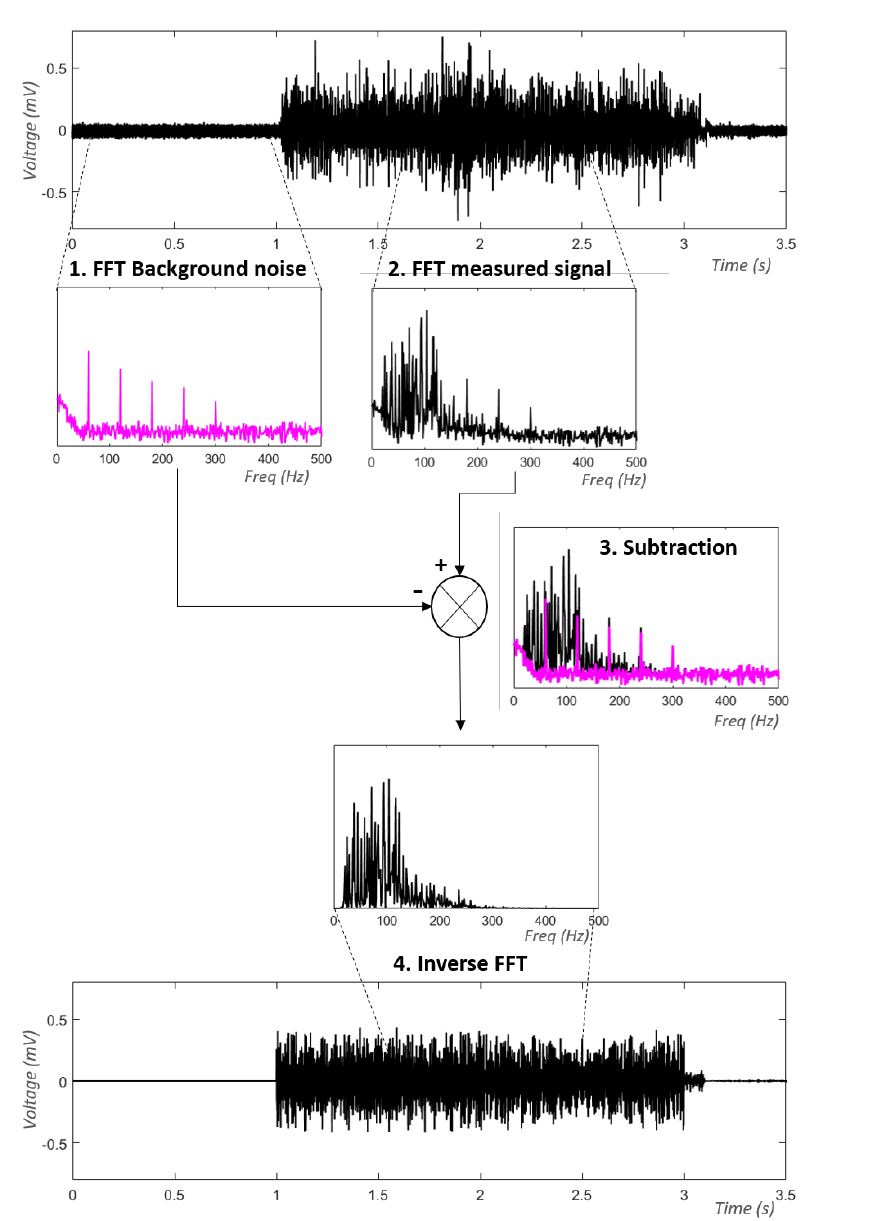
Figure 8. General scheme of the method proposed by [17] to remove background noise from the EMG signal : 1. Estimation of the power spectrum coefficients of the Background noise by performing a fast Fourier transform (FFT) on the noisy signal (the electrode is placed on the skin, but the muscle is not contracted), 2. Estimation of the power spectrum coefficients of the measured signal during contraction using the FFT, 3. Subtraction of the noise coefficients from the measured coefficients and 4. Reconstruction of the signal using the inverse Fourier